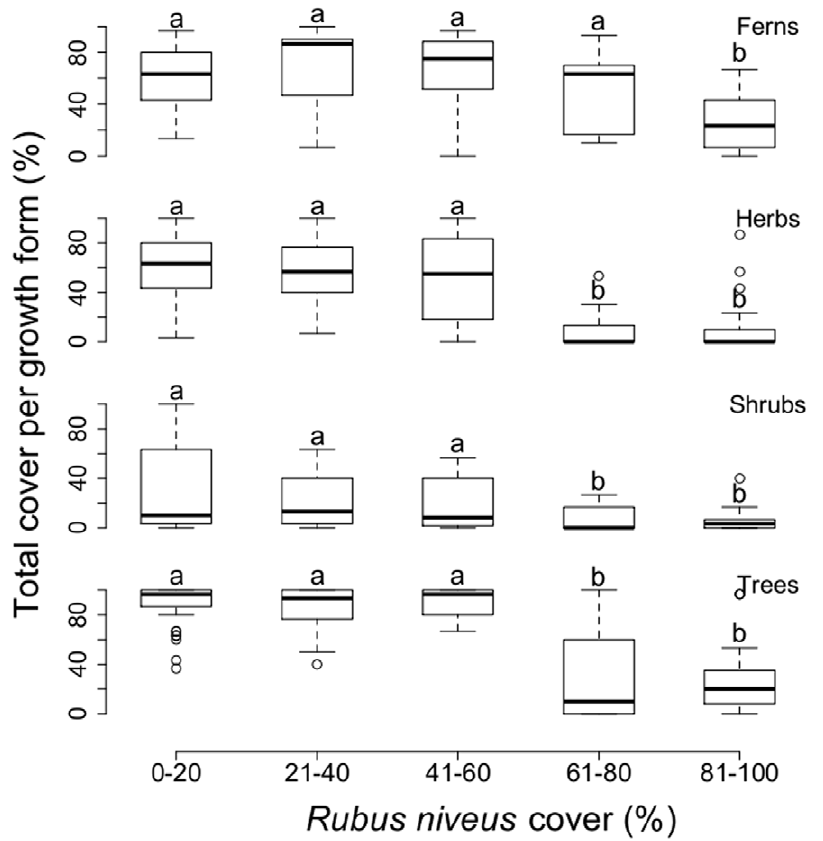
Figure 4. Relationship between R.niveus cover categories and total species cover by growth form. Lines within the box represent the median values of cover within each invasion category; the bottom and top edges of the box represent 25th and 75th percentiles of all data, respectively; the bottom and top bars represent 5th and 95th percentiles. ANOVA-GLM (quasi-Binomial error distribution); ferns: F 4,119 =9.54, P , 0.001; herbs: F 4,119 =20.86, P , 0.001, shrubs: F 4,119 =7.27, P , 0.001; trees: F 4,119 =35.41, P , 0.001 ( a,b denote group differences detected by statistical analyses amongst R. niveus cover categories).